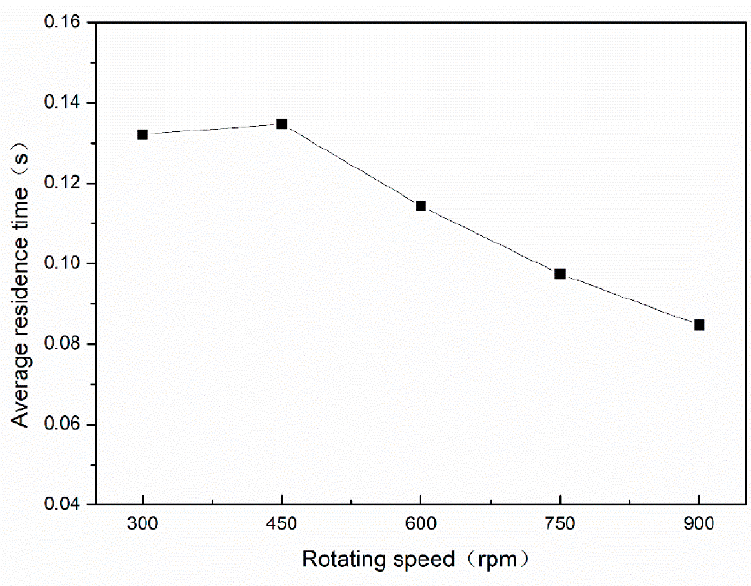
Figure 11. E ff ect of rotating speed on average residence Figure 11. Effect of rotating speed on average residence time.